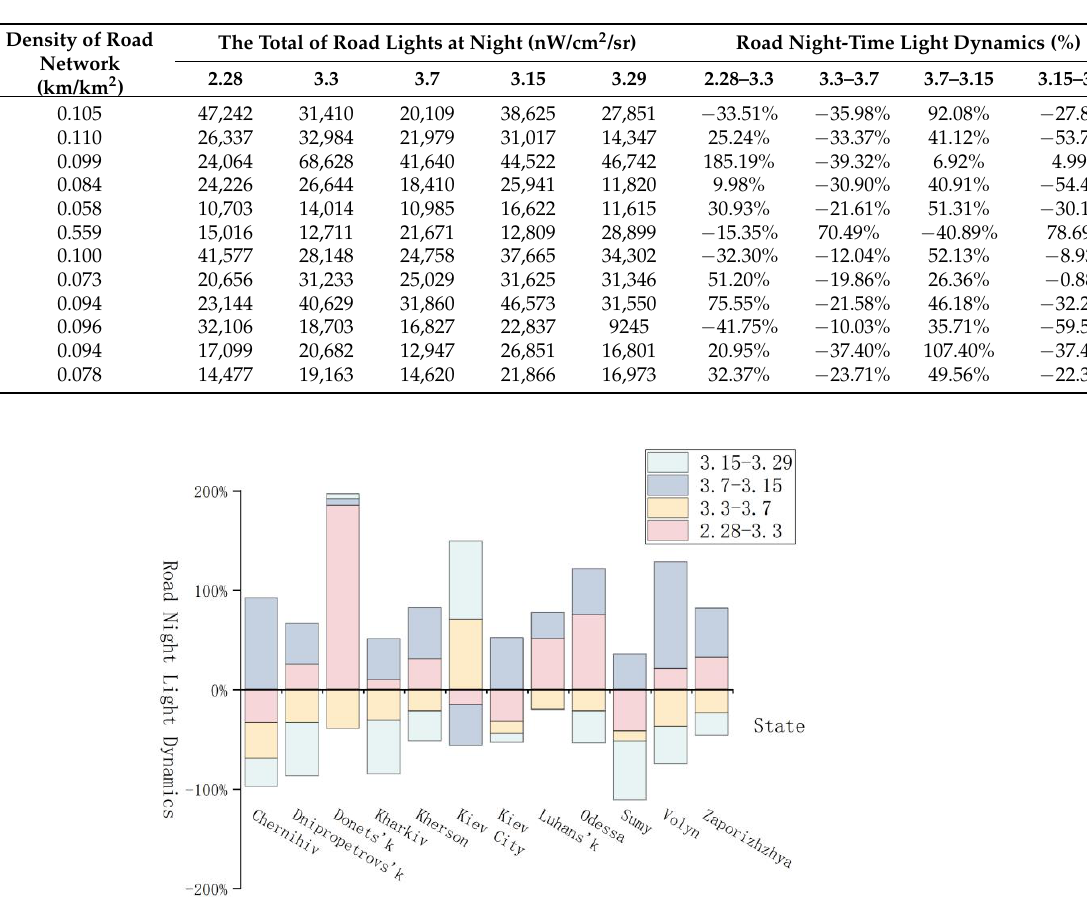
Figure 7. The night-time road light dynamics of twelve regions. Table 3. The night-time road light dynamics of each region in the five times negotiation periods